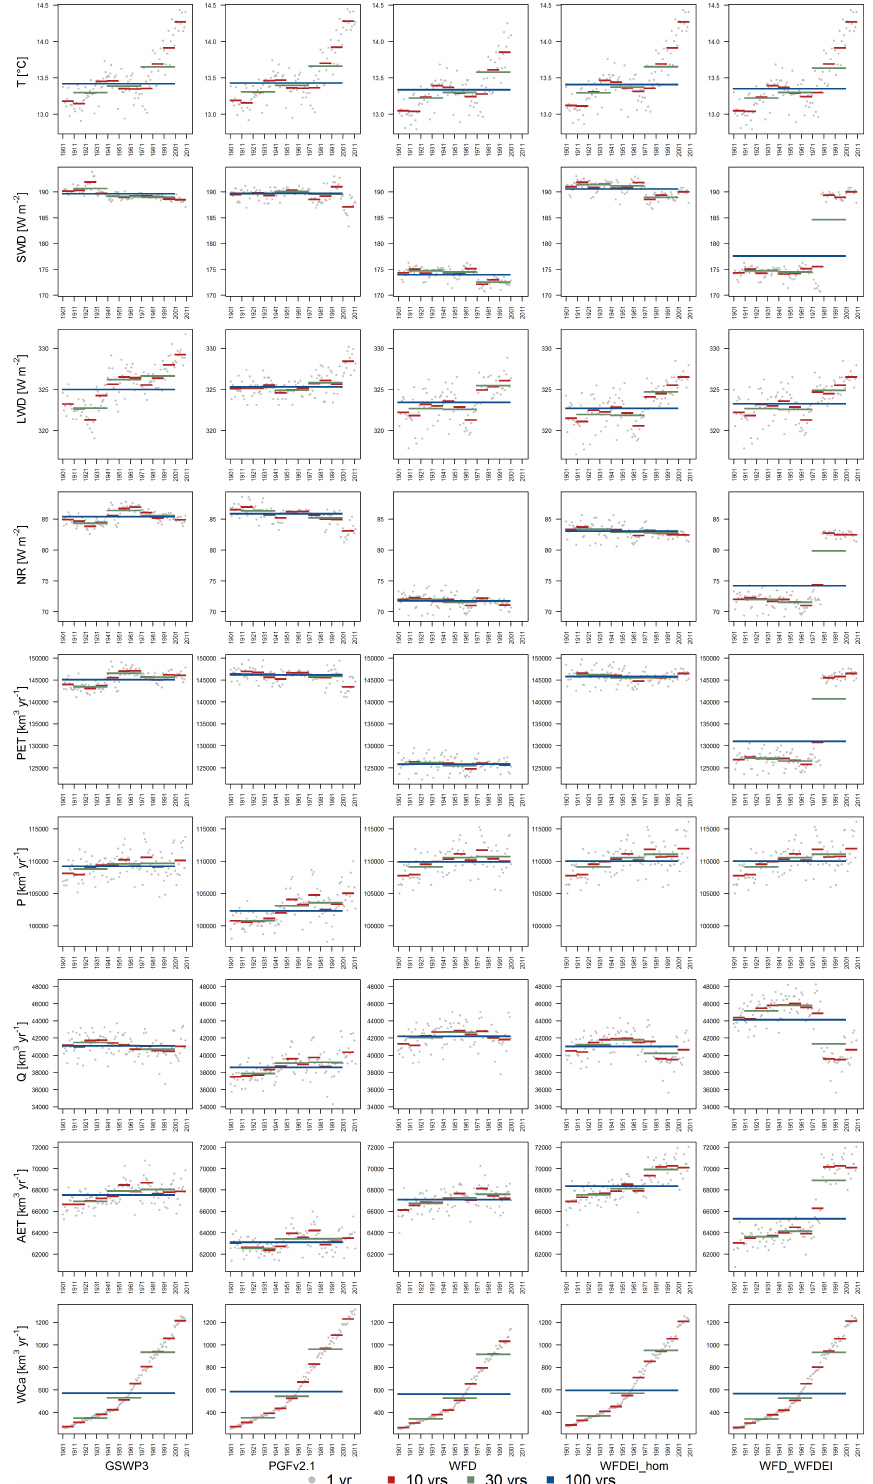
Figure 2. Global sums (means) of climatic variables and water balance components for five climate forcings (GSWP3: 1901–2010, PGFv2.1: 1901–2012, WFD: 1901–2001, WFDEI_hom: 1901–2010, WFD_WFDEI: 1901–2010) for different temporal aggregation periods of 1, 10, 30, and 100 years. Displayed are temperature ( T ), shortwave downward radiation (SWD), longwave downward radiation (LWD), precipita- tion ( P ), discharge into the ocean or inland sinks ( Q ), actual evapotranspiration (AET), and (actual) water consumption from surface water resources (which could be smaller than the demand, depending on water availability) and groundwater resources